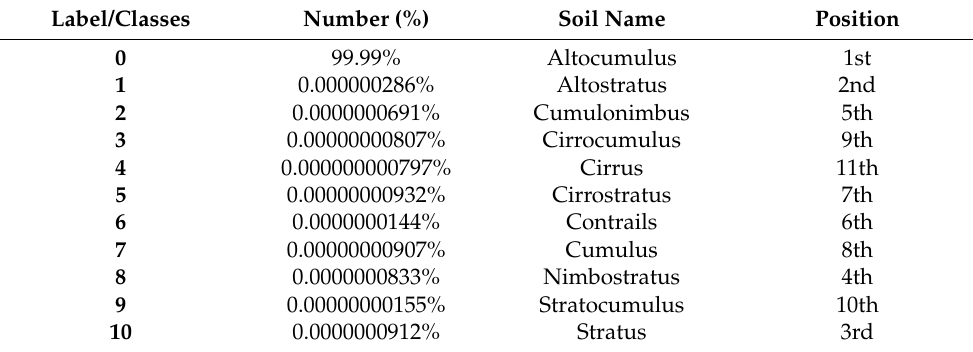
Table 3. Outline of the model’s percentage confidence for the predicted Figure 8 sample image.